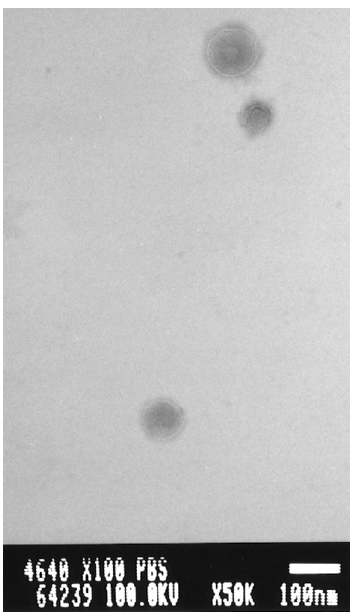
Figure 6. Transmission electron microscopy image of the vesicle formation from the PBL mixture after size-exclusion chromatography.